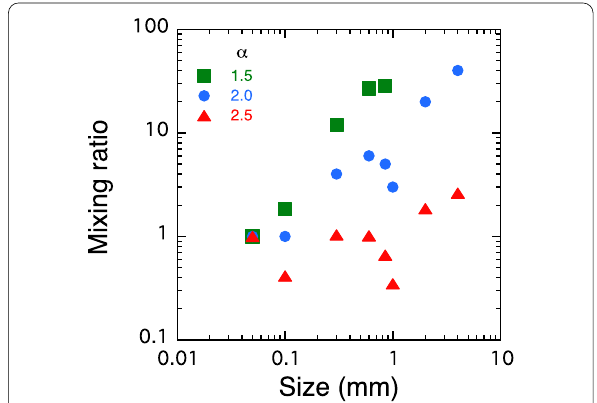
Fig. 1 Mixing ratio of glass beads. The total mass of glass beads for each size normalized by the total mass of 50 μm beads is shown as a function of bead sizes. The value of α is the power-law exponent of the cumulative number of target constituent glass beads. The ratio for each size is listed in Table